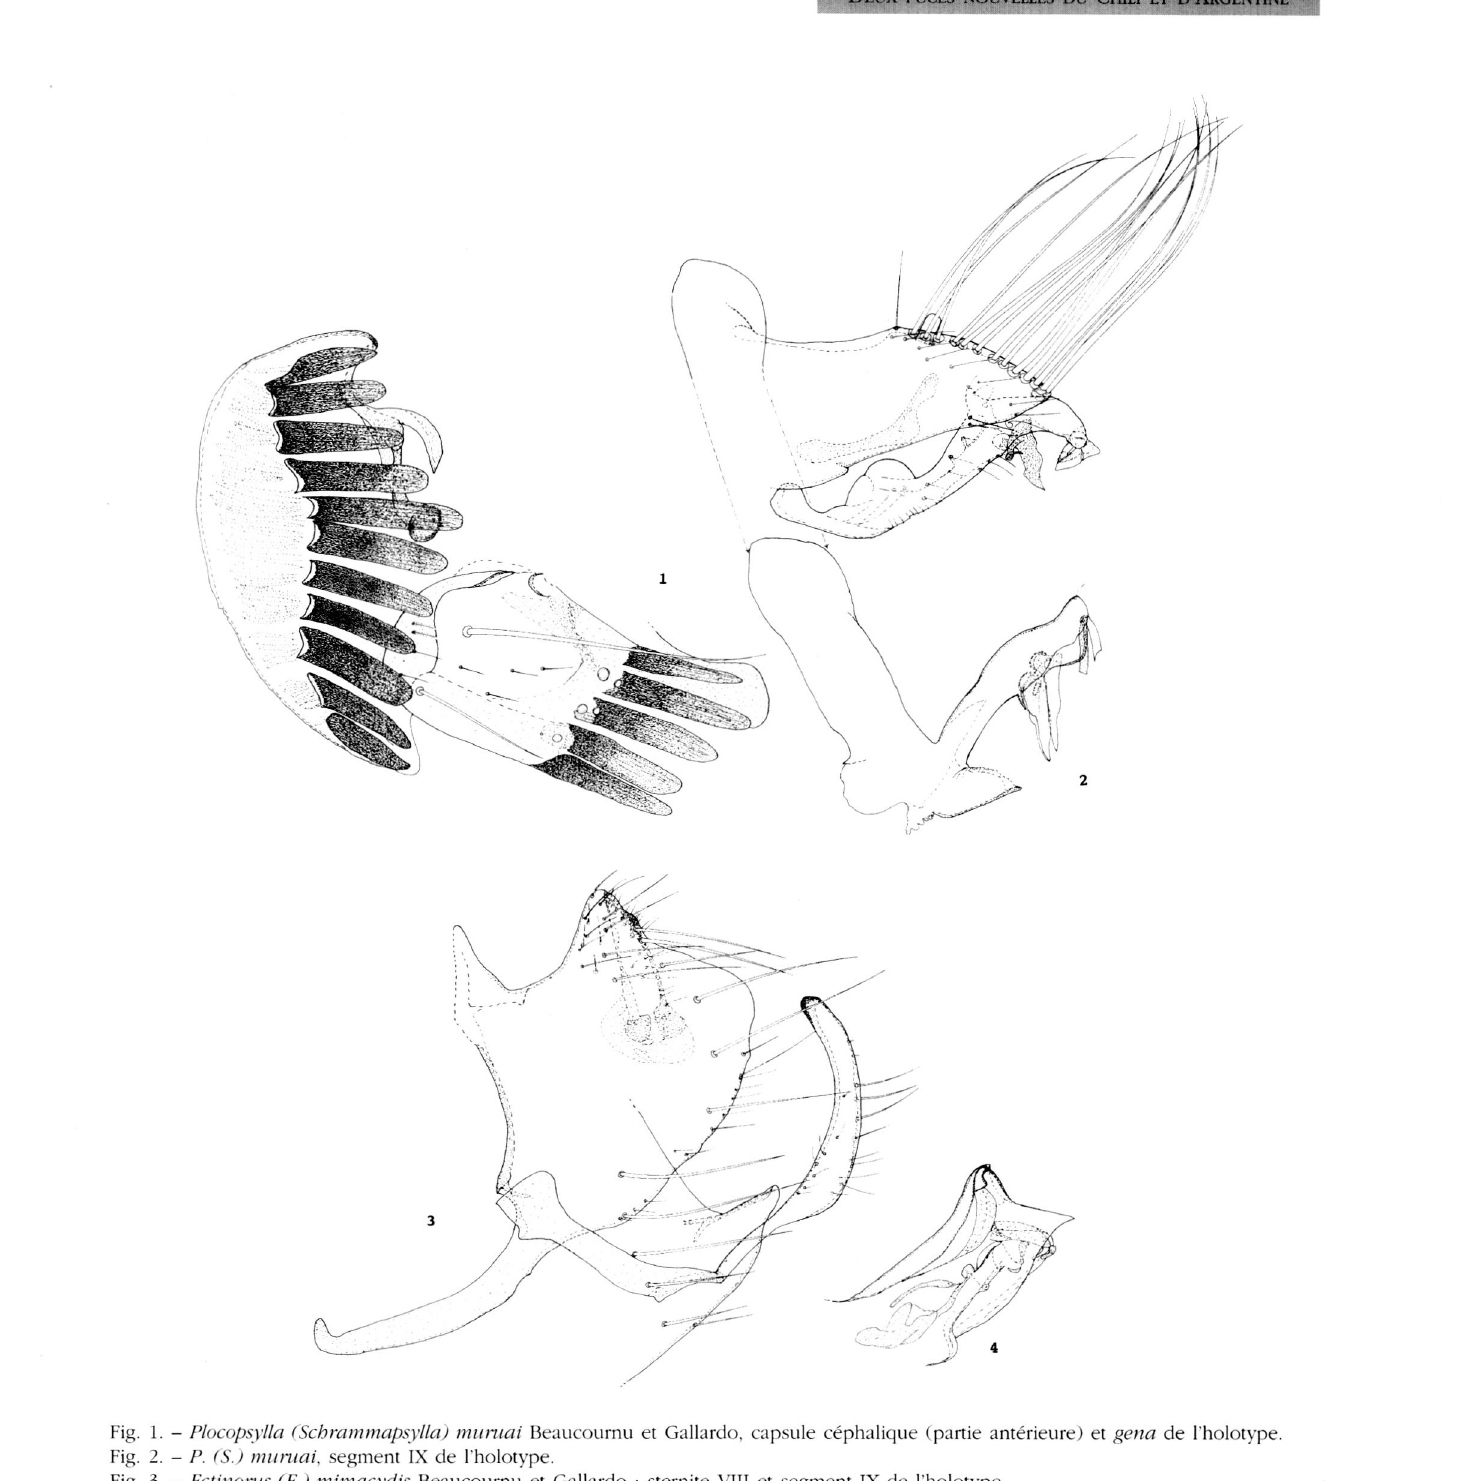
Fig. 1. - Plocopsylla (Scbrammapsylla) muruai Beaucournu et Gallardo. capsule céphalique (partie antérieure) et gena de Pholotype. Fig. 2. - P. (S.) muruai, segment IX de l'holotype. Fig. 3. - Ectinorus (E.) mimacydis Beaucournu et Gallardo : sternite VIII et segment IX de l'holotype. Fig. 4. - E. (E.) mimacydis, apex de l'aedeagus de